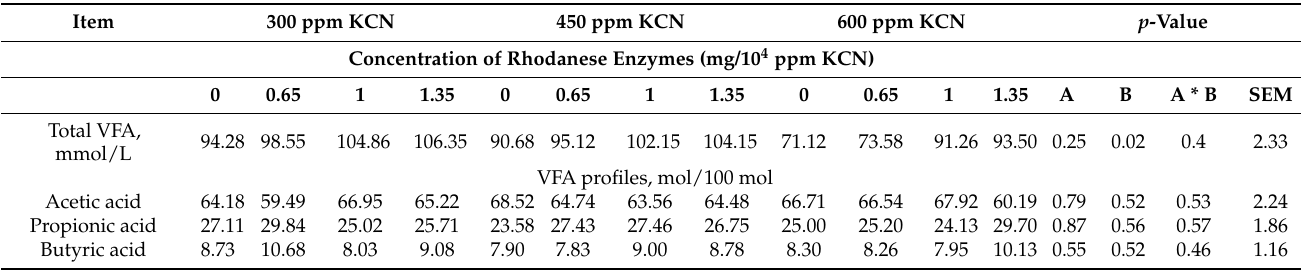
Table 4. Addition of rhodanese enzymes and potassium cyanide (KCN) levels on in vitro total volatile fatty acids (VFAs) and VFA